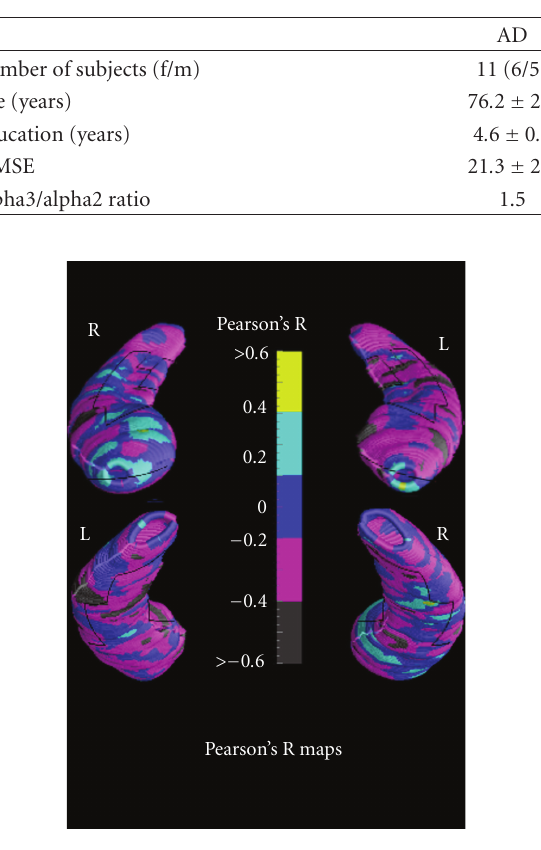
Figure 2: Correlation between alpha3/alpha2 power rhythm ratio and volumes of hippocampal subregions in AD